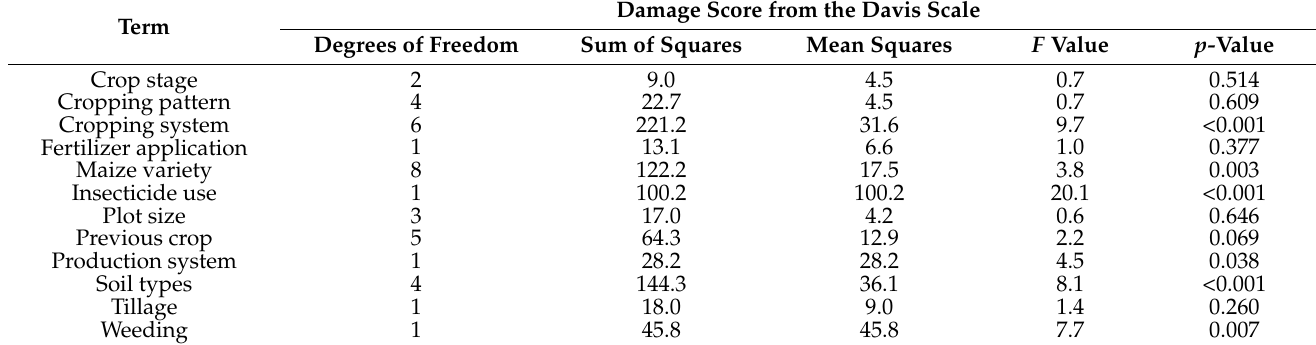
Table 5. Analysis of variance results for the aggregated data on maize field characteristics and crop management practices employed by smallholder farmers interviewed during the survey for fall armyworm infestation and damage in three agro-ecological zones of Kenya in